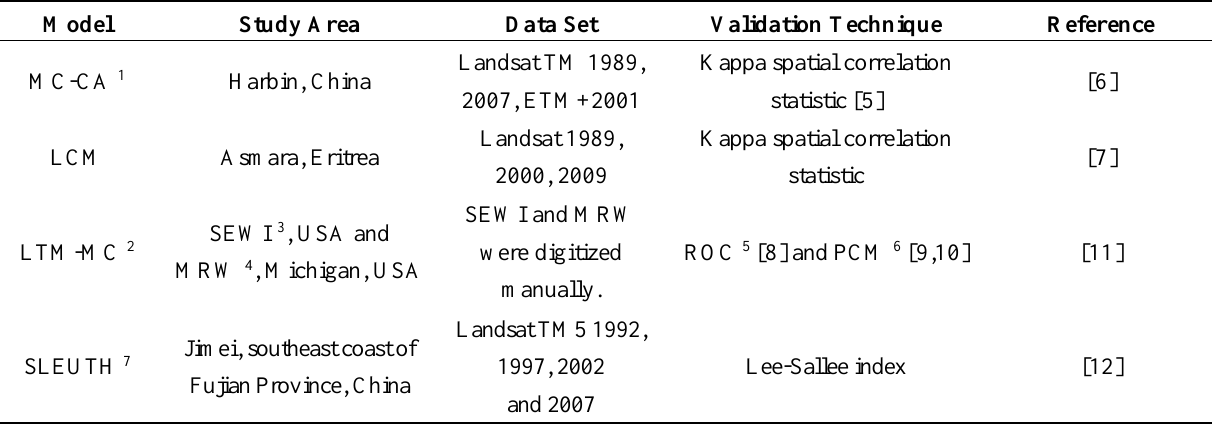
Table 1. Different Land Use Land Cover Change (LULCC) models in recent